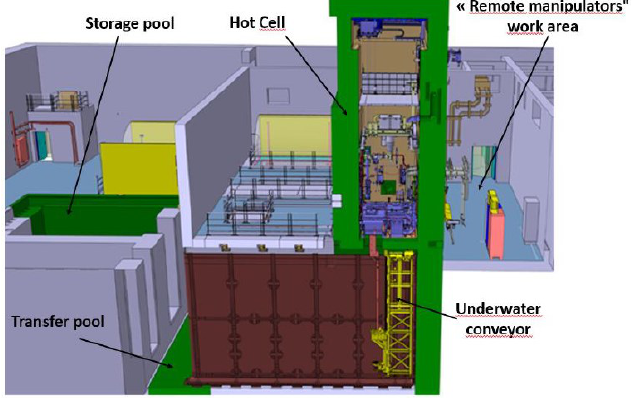
Fig. 4. Geometry used in the